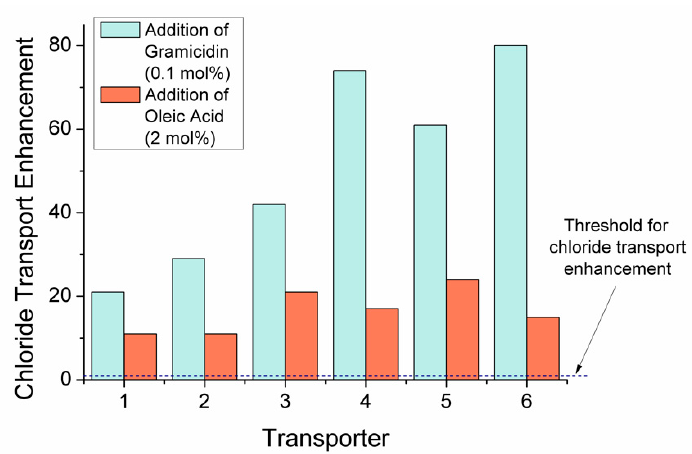
Figure 6. Chloride transport enhancement results. In the presence of Gra, a factor of chloride transport enhancement, F Gra , (green) is calculated by dividing the EC 50 (BSA) by the EC 50 (Gra) . Factor of enhancement in the overall rate of Cl − /H + cotransport in the presence of OA, F OA (orange), is calculated by dividing the EC 50 by the EC 50 (OA) . Values over the threshold (>1) indicate an increase in the rate of chloride transport in the conditions described.